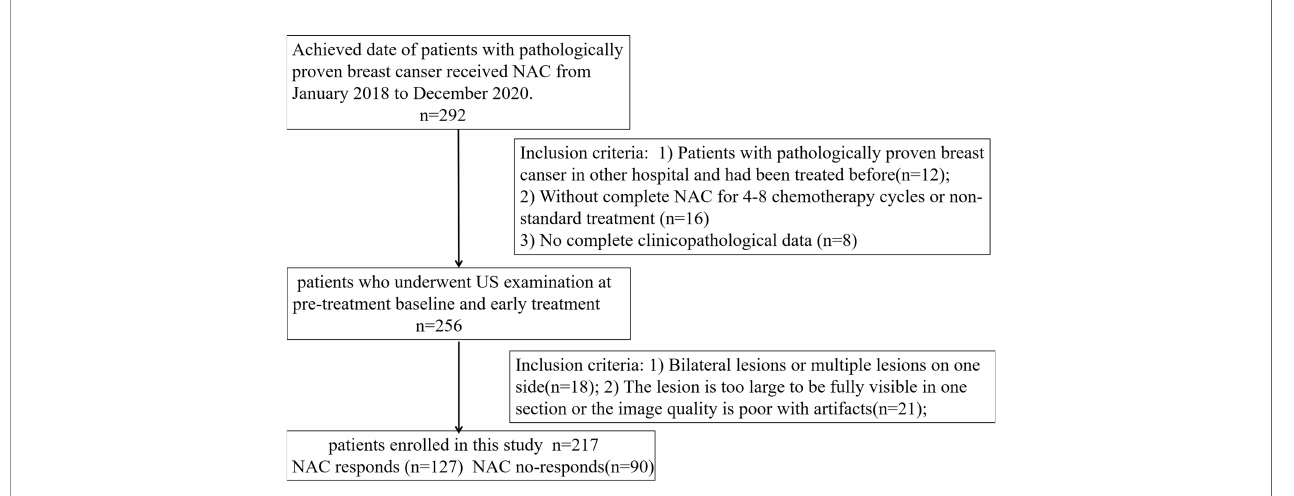
FIGURE 1 | Flowchart shows study population and exclusion